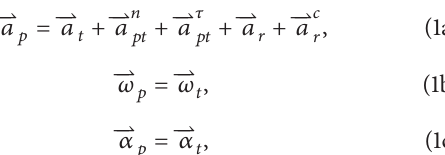
Figure 1: The 3D pack and trunk motions during load carriage and the three coordinate systems. 𝑂𝑋𝑌𝑍 is the global (inertial) coordinate system, 𝑜 𝑡 𝑥 𝑡 𝑦 𝑡 𝑧 𝑡 is the trunk coordinate system, and 𝑥 𝑦 𝑧 𝑜 𝑝 𝑝 𝑝 𝑝 is the backpack coordinate